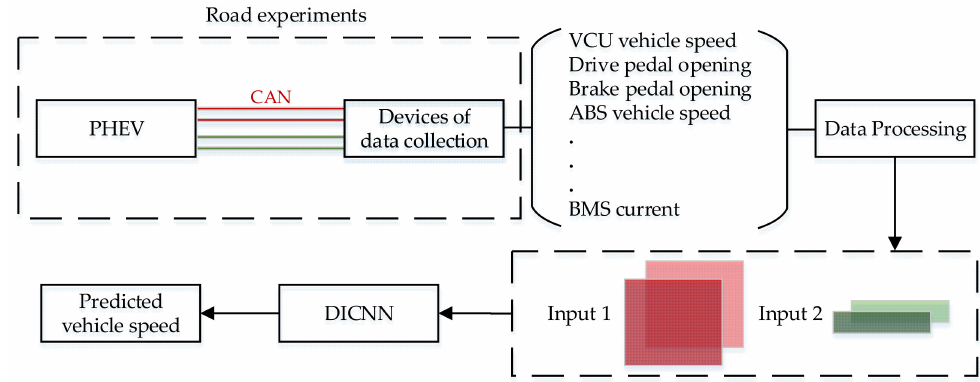
Figure 1. Flow chart of vehicle speed